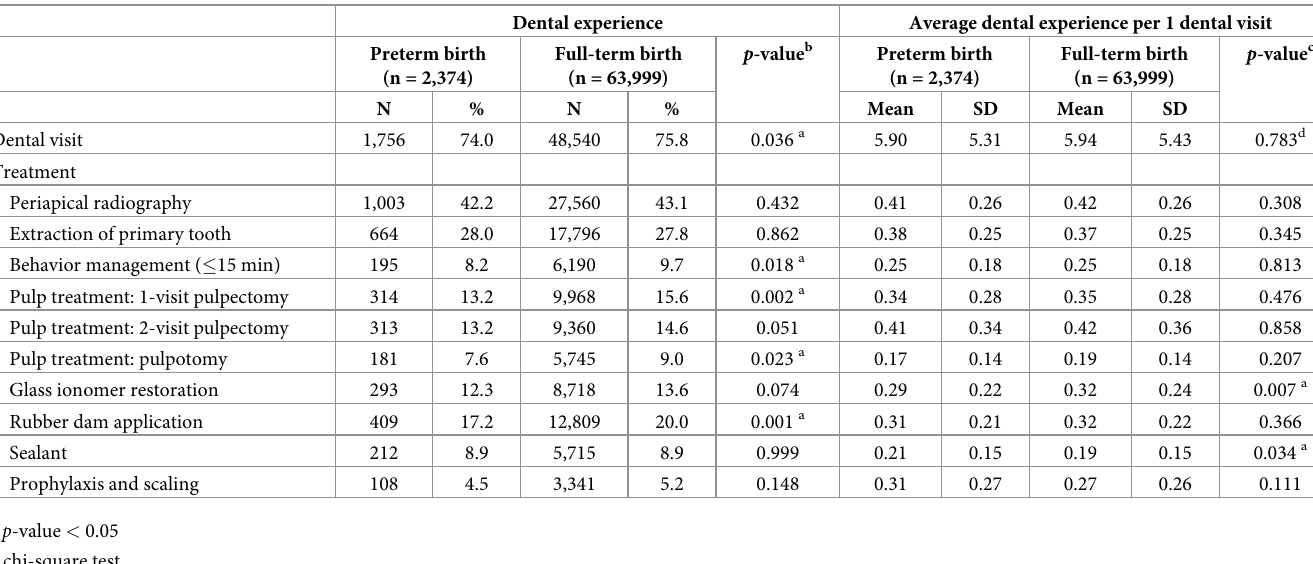
Table 4. Comparison of dental treatments between preterm and full-term children.